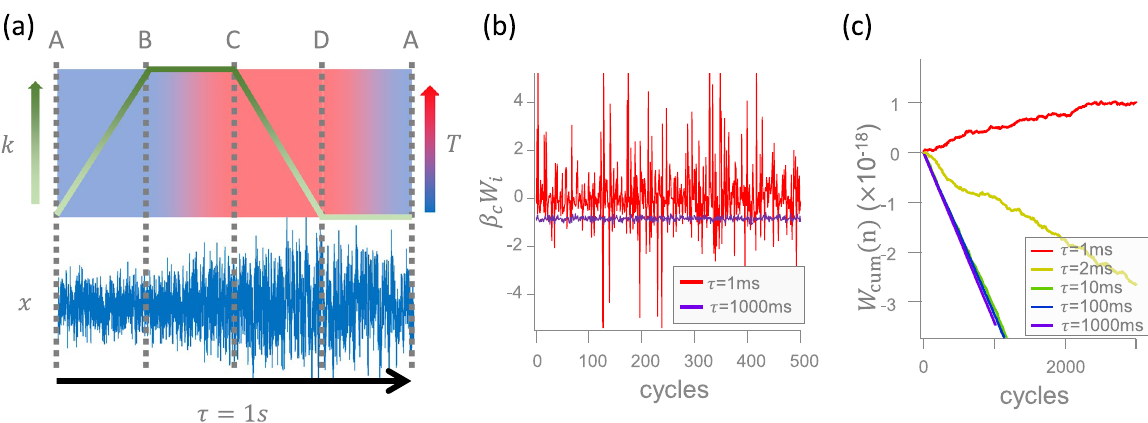
Figure 5. ( a ) (Top panel) A schematic drawing of the single cycle of a microscopic Stirling engine. The white- k eff , of the virtual harmonic potential from k min green arrow denotes the increase of the stiffness, k v = 20 pN/ µ m and the blue-red arrow represents the increase of the kinetic temperature, pN/ µ m to k max = 300 K to T h 1000 K. In process A T kin T eff , from T c B (iso- T compression), k eff rises linearly from k min → = = = to k max at T c . In process B C (iso- k expansion), T eff rises linearly from T c to T h at k max . In process C → expansion), k eff falls linearly from k max to k min at T h . In process D A (iso- k compression), T eff falls linearly → from T h to T c at k min . (Bottom panel) A trajectory of the Brownian particle during a single cycle. The magnitude of its position fluctuations depends on the values of k eff and T eff . ( b ) Work fluctuations during 500 cycles of cycle 1 ms (red) and 1s (purple). ( c ) The cumulative sums of work (the integrals of the curves in ( b )) for time τ = various τ